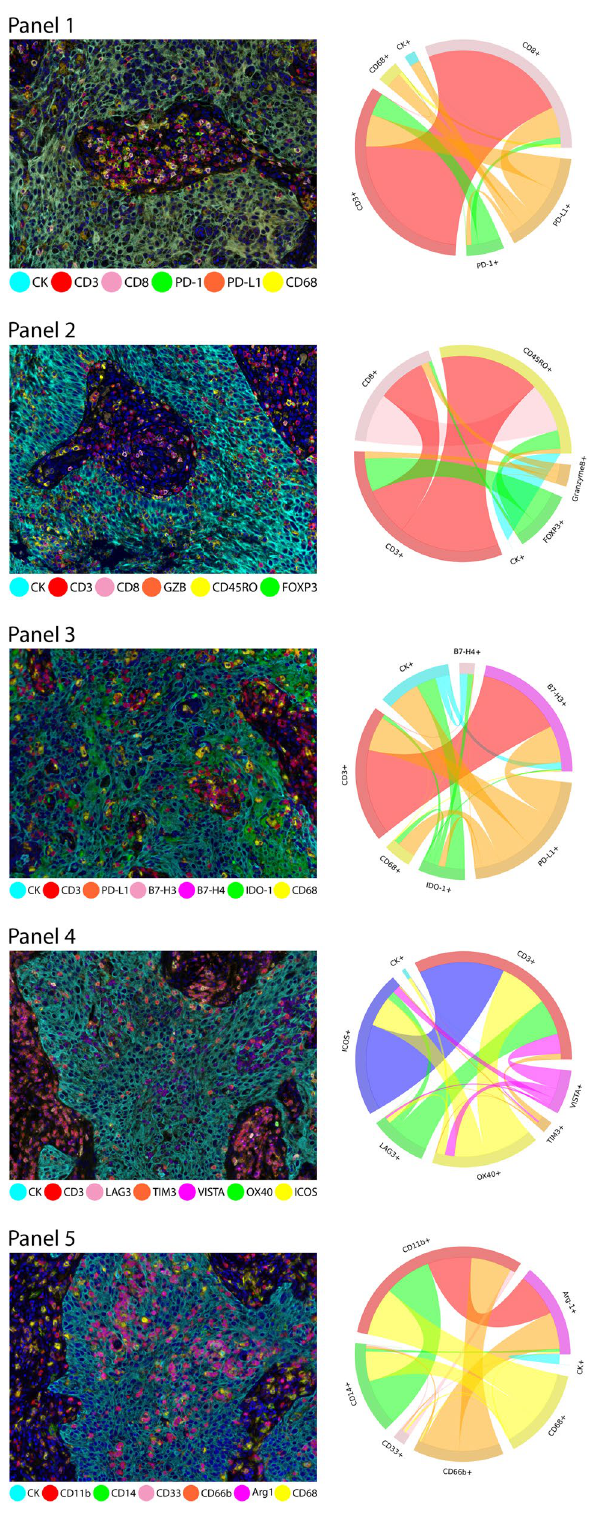
Figure 1. Microphotographs of representative examples of multiplex immunofluorescence (mIF) and cord plots of cells co-expression of makers in the different immuno-oncology panels in the NSCLC cohort. For each panel, the composite mIF images (left) and the diversity of cell phenotypes by the markers co-expressed (right) are shown. mIF 20 × magnification. The images were generated using Vectra-Polaris 3.0.3 scanner system